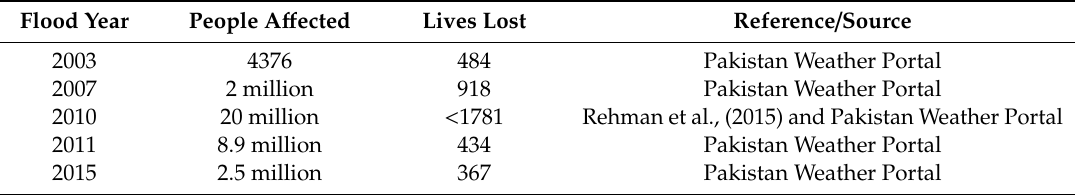
Table 1. Incidence of floods in Pakistan during the last two